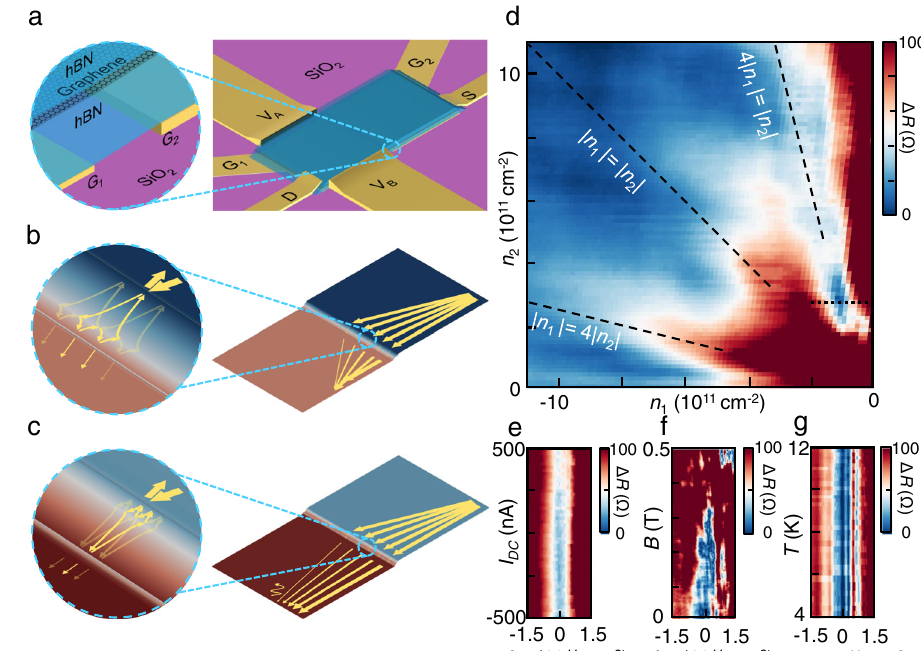
Fig. 4 | Enhancing collimation with second-order Veselago interference. a Device diagram demonstrating the collimation of small-incident-angle electrons with Veselago interference. Carriers are injected from the source contact and fi rst collimated (ineffectively) by the cavity wall. b When | n 1 |<| n 2 |, the u n collimated car- riers that escape the cavity predominantly reach voltage probe B, while Veselago interference further localizes uncollimated carriers in the cavity at 4| n 1 |=| n 2 |. This